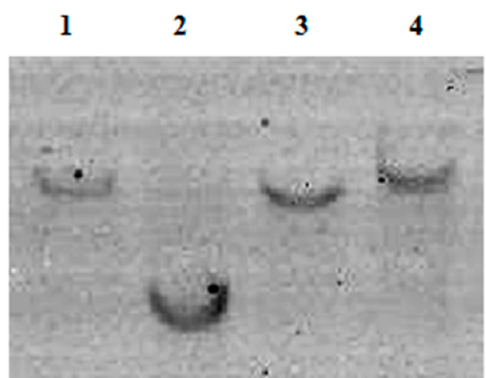
Figure 4. Southern blot result. 1, Jilin Yanbian T. matsutake digested by EcoR I; 2, Jilin Yanbian